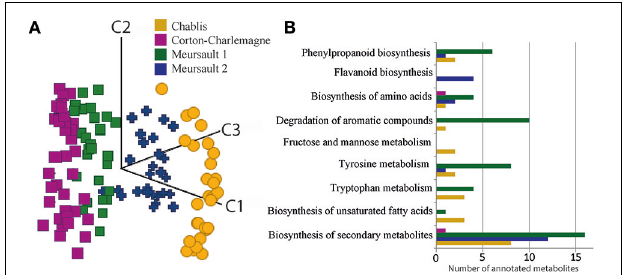
FIGURE 5 | (A) PCA score plot for the first three components from RP-UPLC-QToF-MS data sets of white wines, from three distinct appellations in Burgundy, showing the discrimination between wines according to the appellation, regardless of the age of the wine. (B) Number of metabolite structures that could be associated with elemental formulas specific to the different geographical origins, in some of the Vitis vinifera metabolic pathways, using